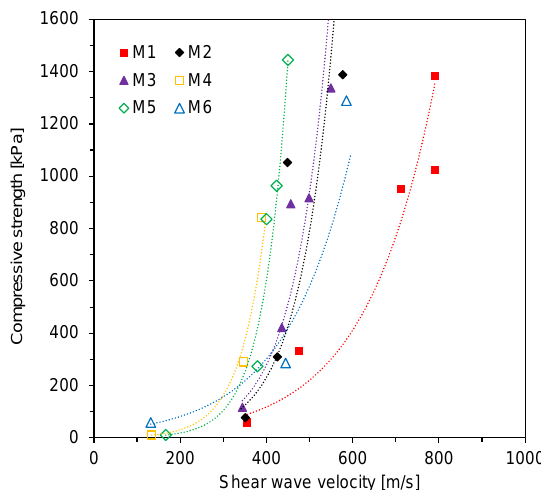
Figure 9. Compressive strength versus shear wave velocity.